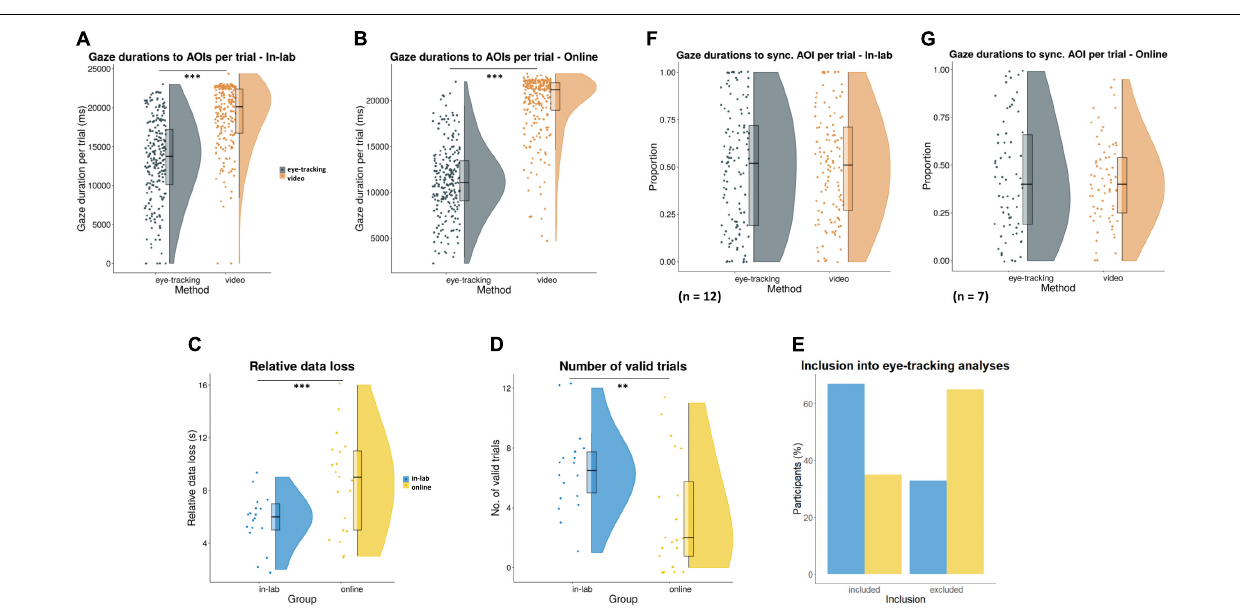
FIGURE 8 | Screen viewing compared between in-lab and online settings, in terms of (A,B) gaze durations to the AOIs per trial, recorded by the eye-tracker/webcam and coded from the videos ( ∗∗∗ p < 0 . 001); (C) relative data loss from the eye-tracker compared to video recording ( ∗∗∗ p < 0 . 001); and (D) number of valid trials (eye-tracking data recorded at least for 70% of the video duration; ∗∗ p < 0 . 01). (E) The proportion of participants included into subsequent eye-tracking analyses (based on at least two valid trials per condition). (F,G) For participants with sufficient data quality, proportions of trial-level fixation/gaze durations to the synchronous AOI (relative to the total fixation/gaze duration to both AOIs) were compared with respective looking times from the video recording within the experimental